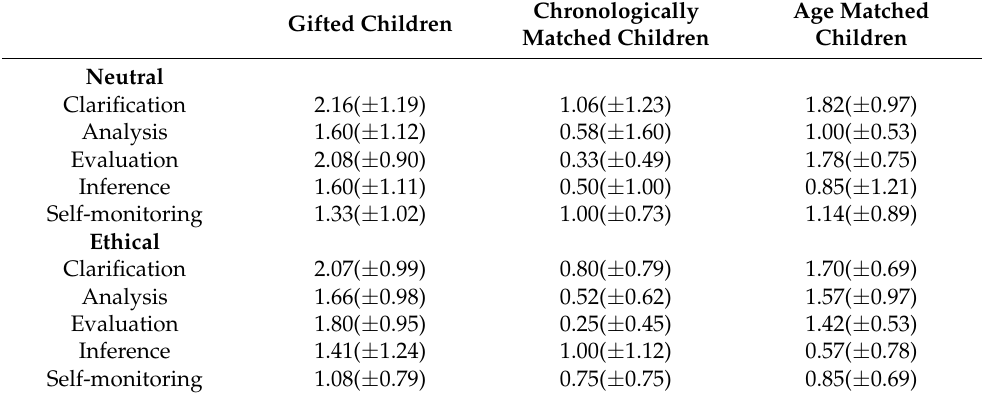
Table 3. Means (and standard deviations) of correct performance on the five phases of critical